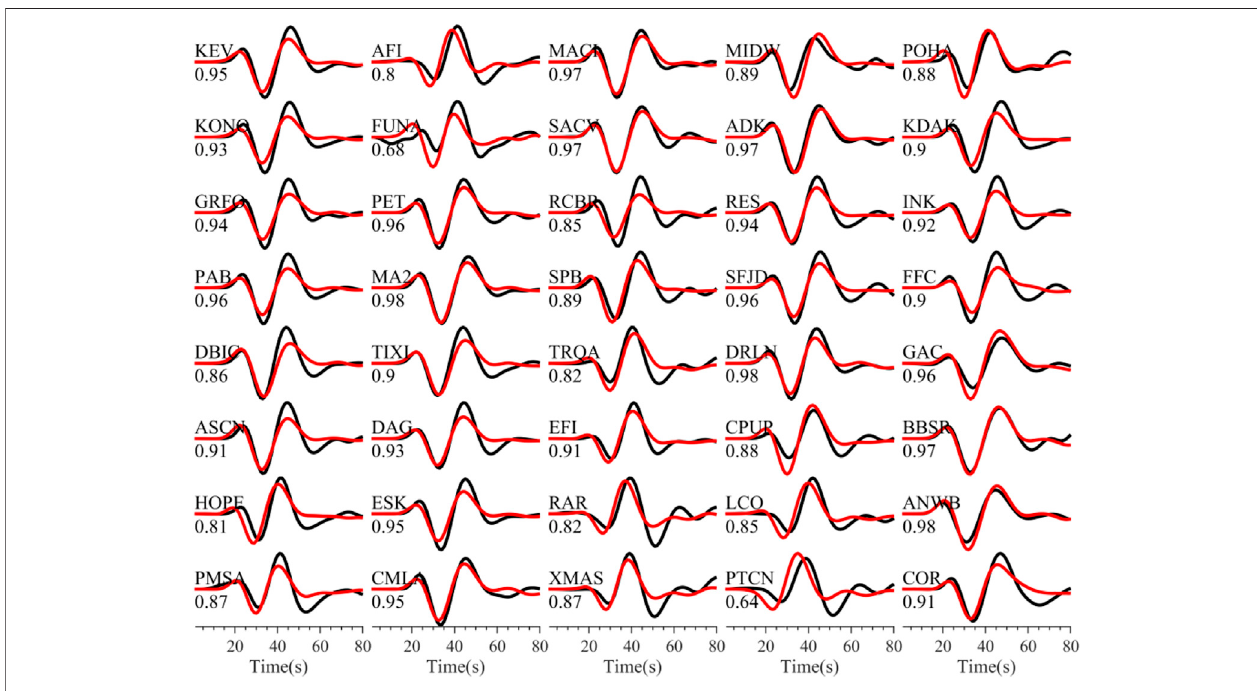
FIGURE 3 | Comparisons of the 40 observed (black) and synthetic (red) teleseismic P waves data. The letters above the waves denote the station name of teleseismic and the digit under the waveforms denotes the correlation coef fi cient between the observed and synthetic waves.